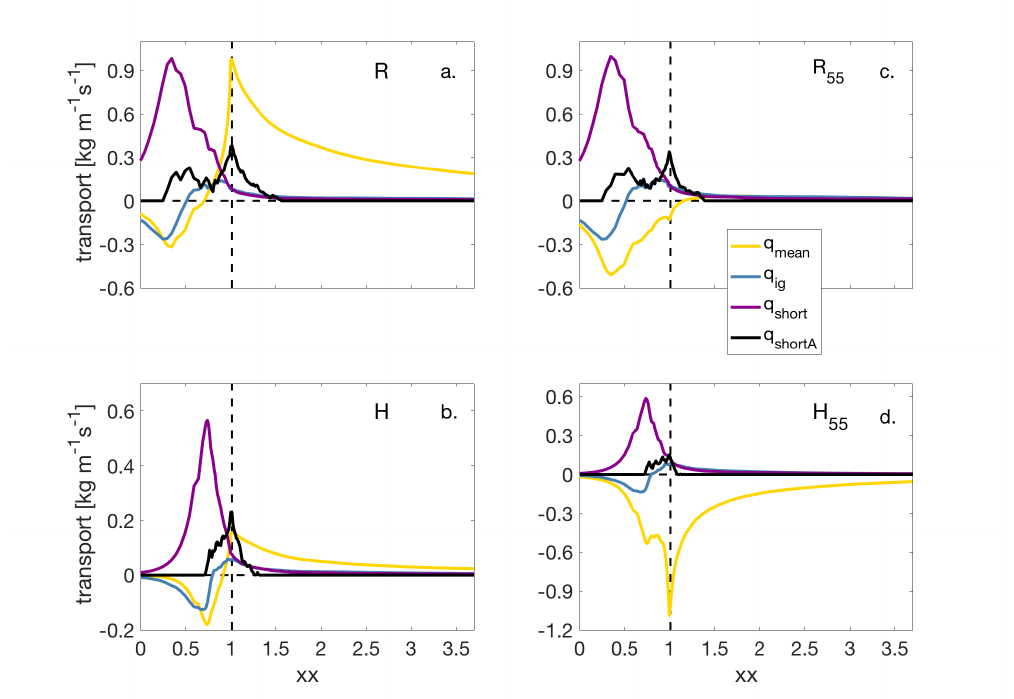
Figure 8. Transport processes q mean , q short , q ig , and q shortA are shown for reference case R ( Hs = 7.45 m) ( a ) and H ( Hs = 4.55 m) ( b ). For R and H the water level in the basin was 0.15 m higher than offshore while it was 0.55 m higher for R 55 ( c .) and H 55 ( d ). The x -axis is the normalized grid ( xx ) from the beginning of the seaward slopes ( xx = 0) to the back barrier basin ( xx = 3.7). Here, the slopes are the same (1:120) and output at all grid locations is in the same water depth. The vertical dashed line indicates the location of the